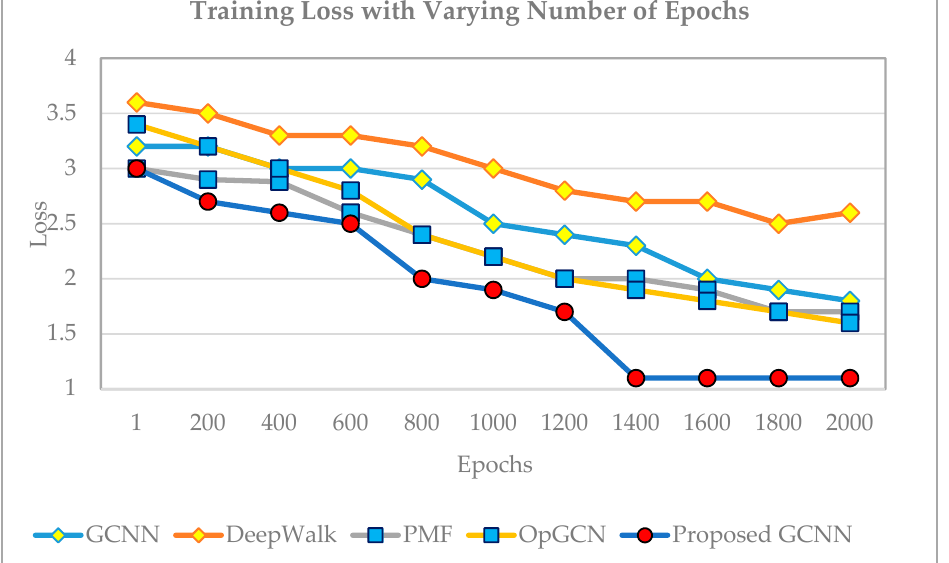
Figure 11. Training loss with respect to epochs.